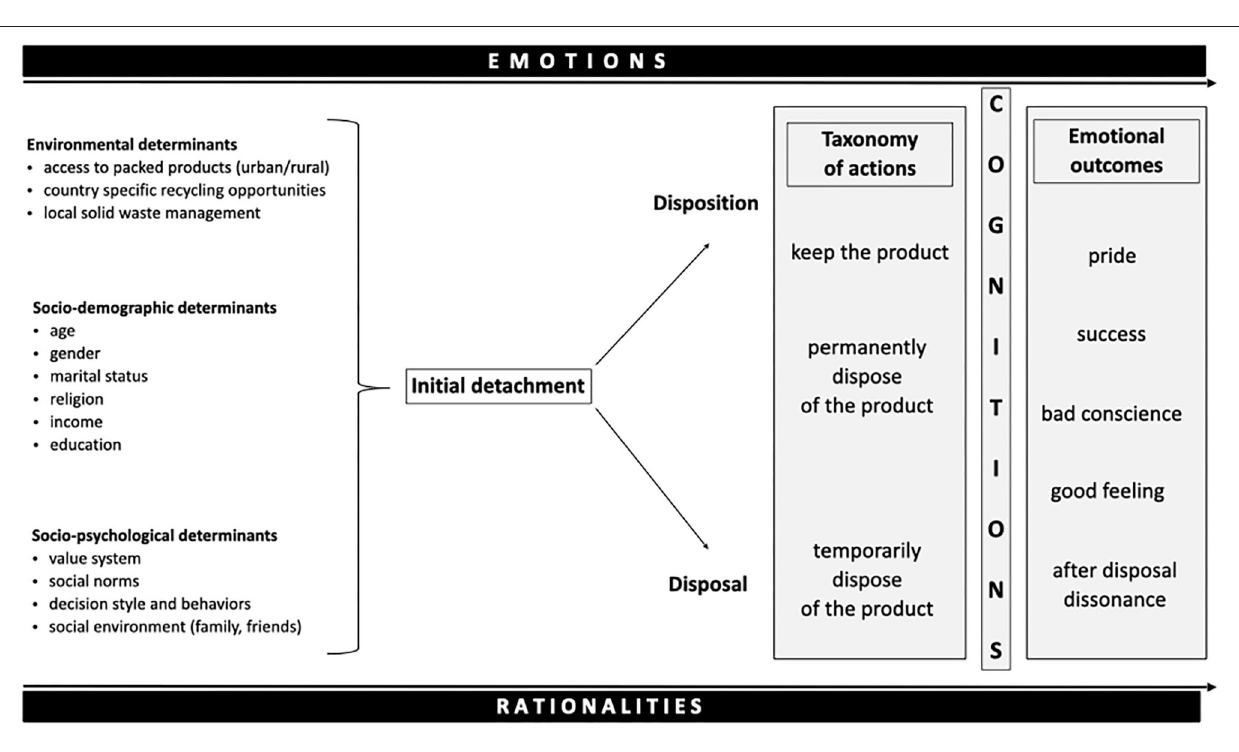
FIGURE 4 | Intervention